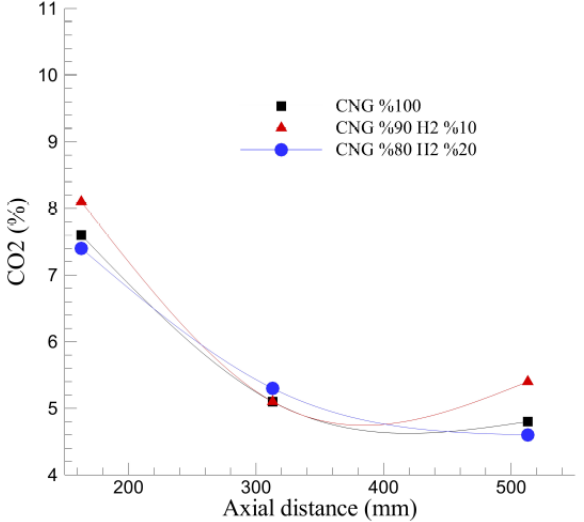
Figure 10: Axial CO 2 concentration profiles (Swirl number: 0.4, Equivalence ratio: